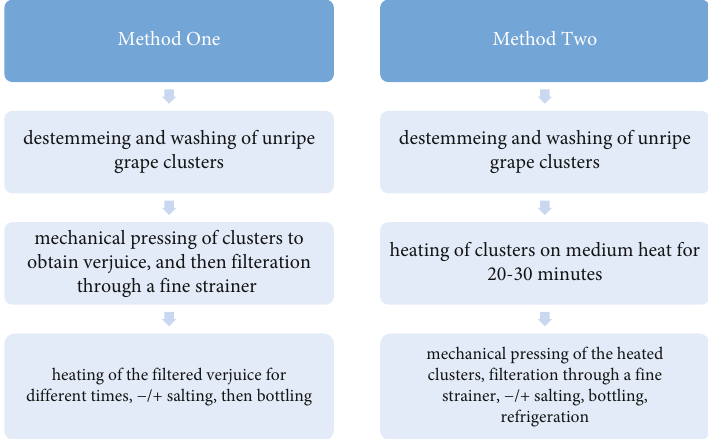
Figure 1: Summary for traditional Lebanese verjuice processing